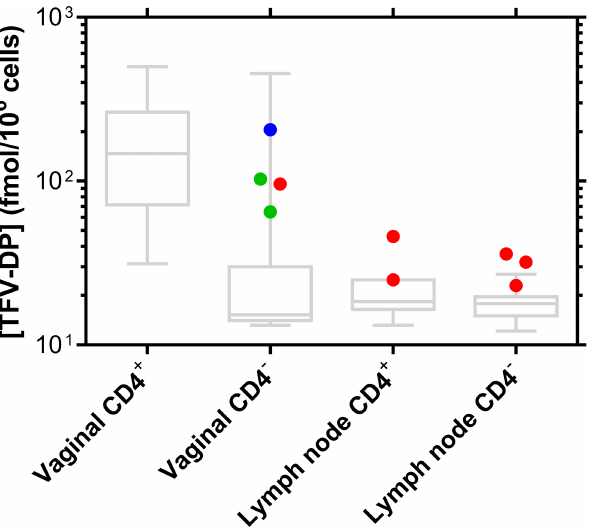
Fig 7. Intracellular TFV-DP concentrations in vaginal tissues and inguinal and iliac lymph nodes collected at necropsy. Blue, Day 34 ( N = 2); red, Day 35 ( N = 2); and green, Day 36 ( N = 2). The intracellular TFV-DP levels are maintained 4–6 days after pod-IVR removalon Day 30. The box plots represent the analyticallower limits of quantitation (LLOQ) associated with the TFV-DP measurements, where the box extends from the 25th to 75th percentiles, with the horizontalline in the box representingthe median; whiskersrepresent the lowest and highestdatum. The assay has an LLOQ of 50 fmol per sample, which is dividedby the numberof cells collectedin each sample to afford the individual LLOQs represented here.